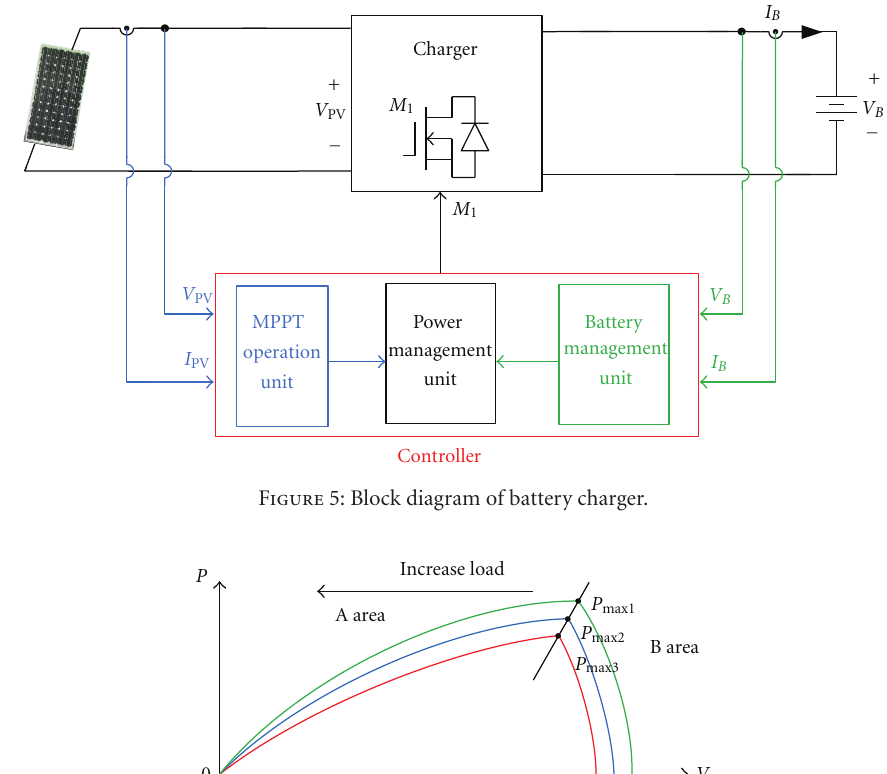
Figure 6: Plot of P - V curves for PV arrays at di ff erent insolations of